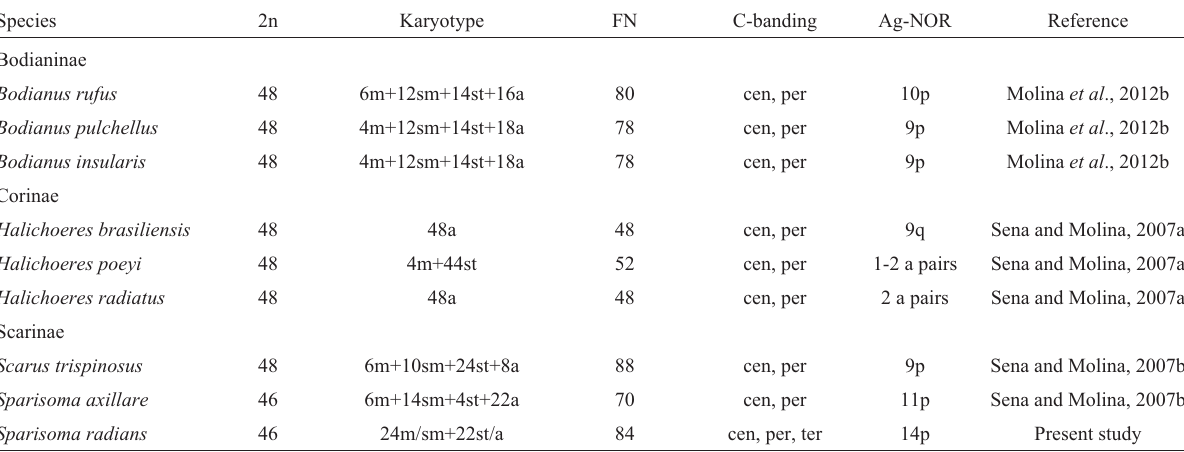
Table 1 - Cytogenetic data in Labridae from South